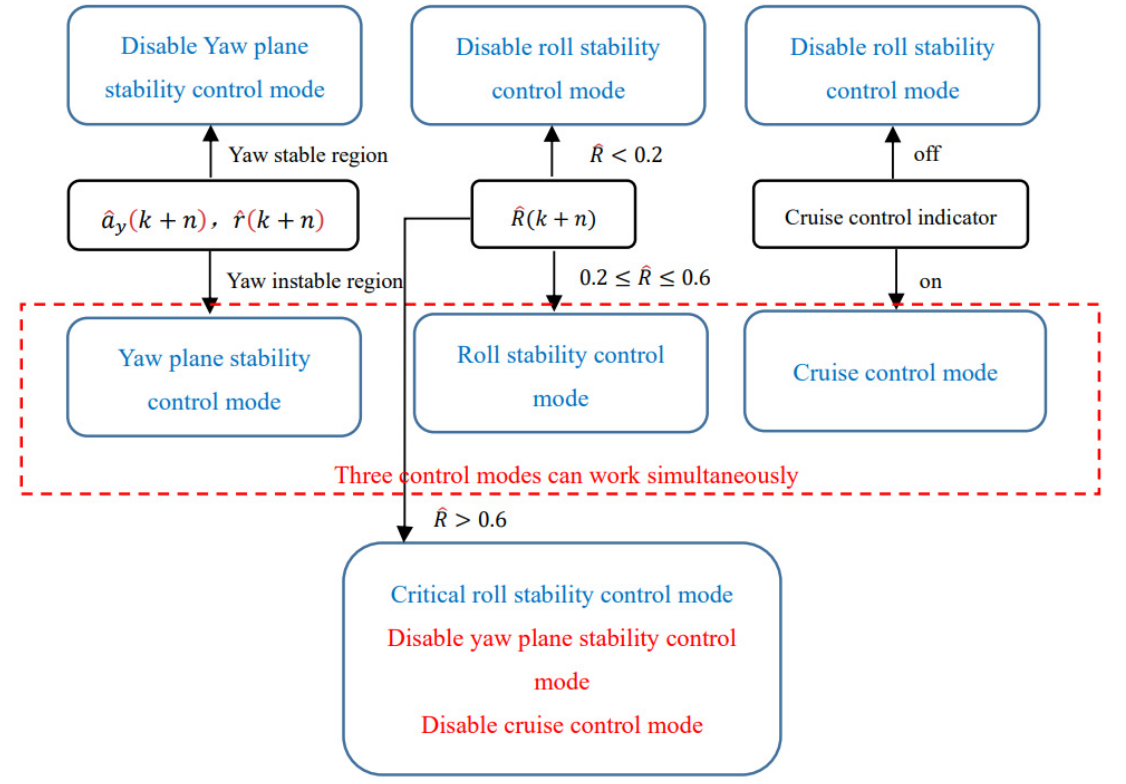
Figure 8. The diagram of the proposed control mode selection rules.